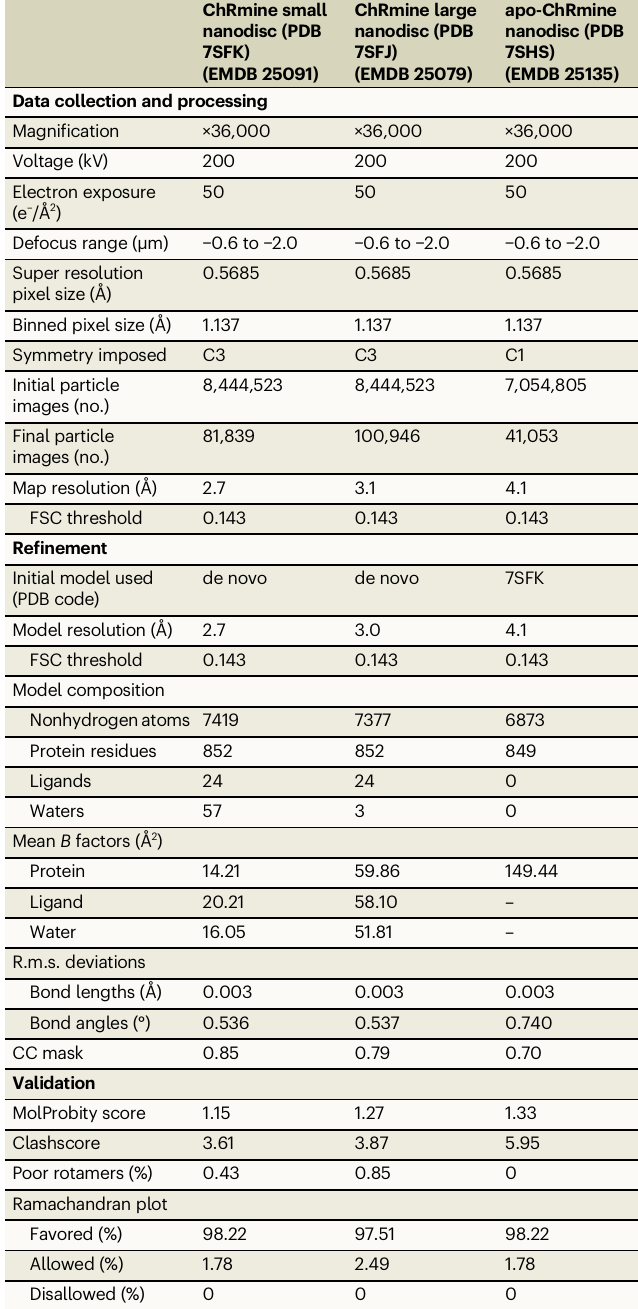
Table 1 | Cryo-EM data collection, re fi nement, and validation